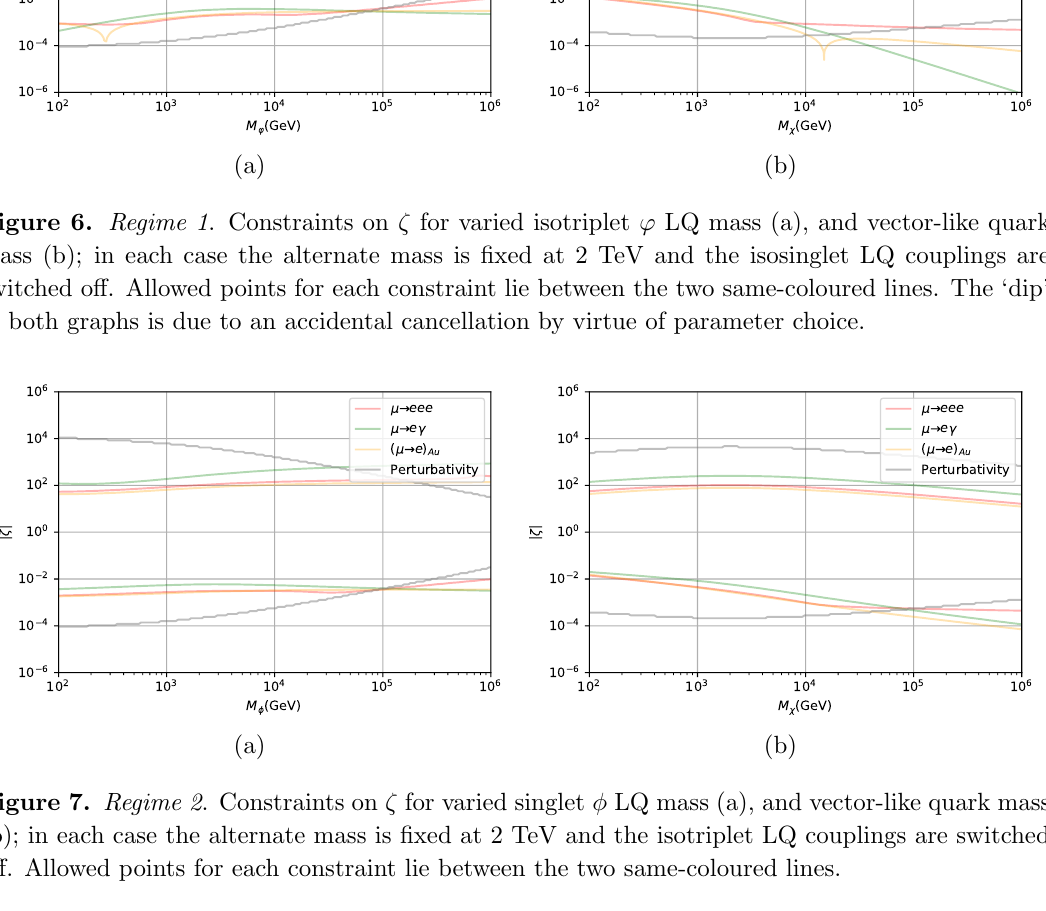
couplings (cid:12)xed by (cid:16) . We have scanned over the magnitude of the Casas-Ibarra parameter, j (cid:16) j . The observables in question are proportional to the product of two LQ couplings gen- erated by the Casas-Ibarra parameterisation, and therefore, / j (cid:16) j 2 . Any phase information is irrelevant for these